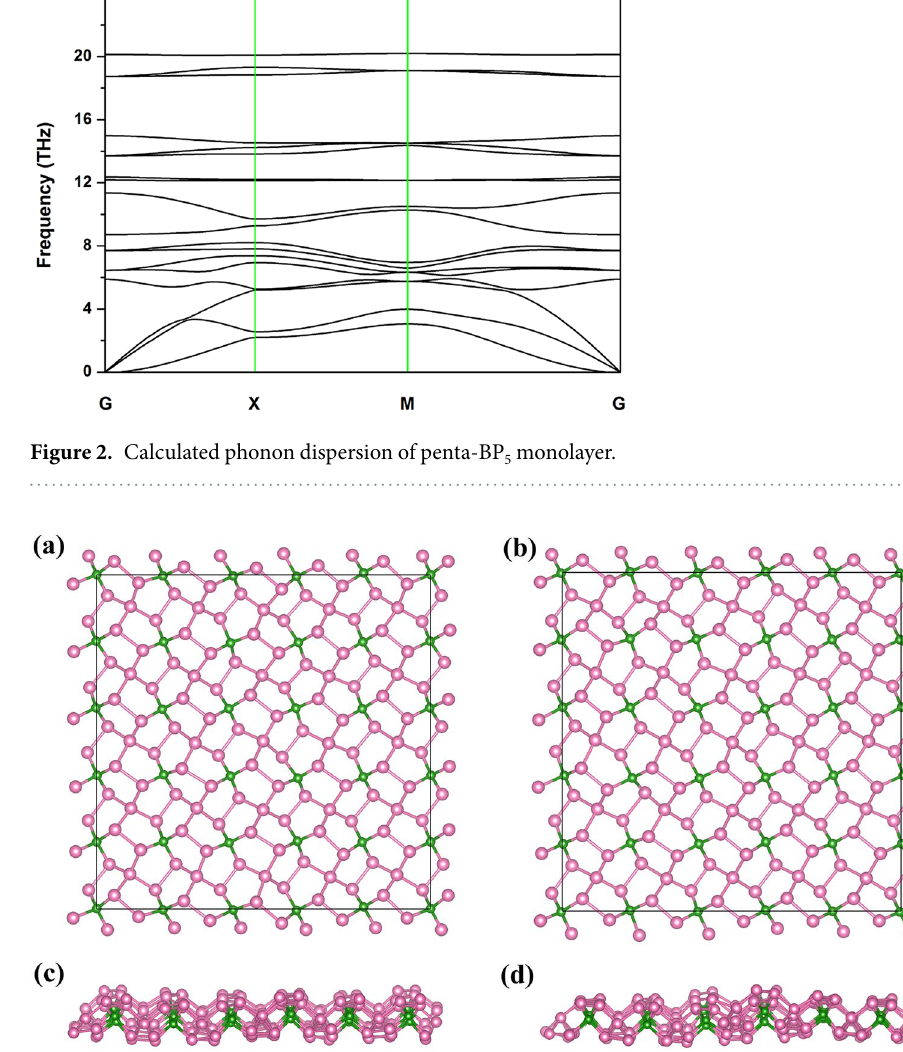
Figure 3. Top and side views of snapshots of the penta-BP 5 monolayer equilibrium structures at 300 K ( a and c ) and 1000 K ( b and d ) after 10 ps in the MD